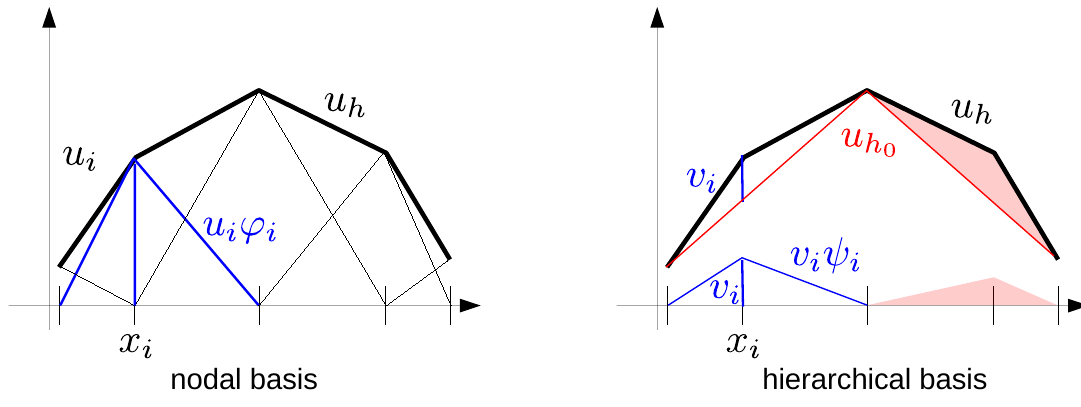
Figure 4. Representation of 1D linear finite element functions u h in the nodal and hierarchical